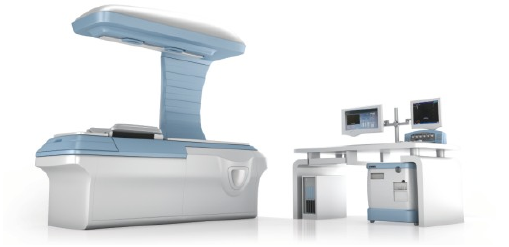
Figure 8. JC200 System with a 6-DoF motion system connected to the patient table for overhead treatment